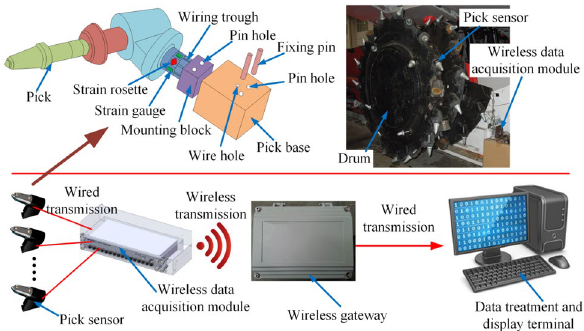
Figure 6. Pick load data acquisition system.